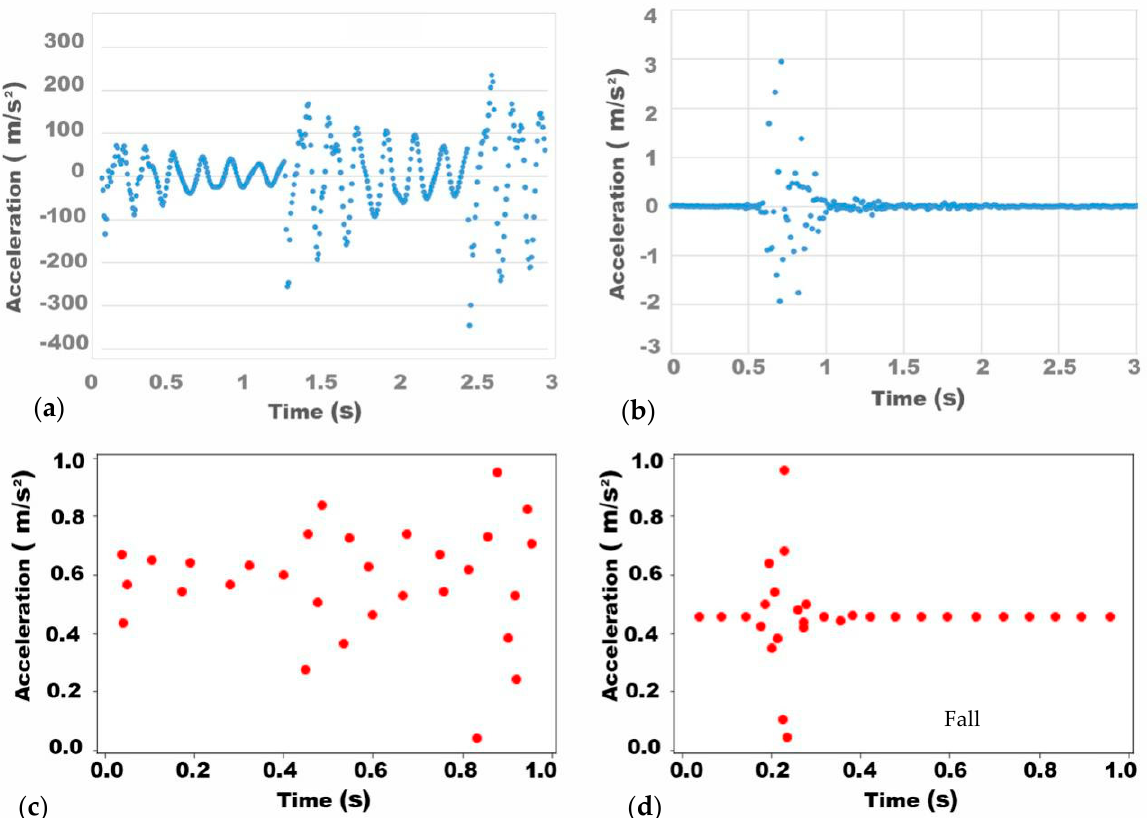
Figure 11. Standardized patterns for walking and fall. ( a ) original walking pattern; ( b ) original fall pattern; ( c ) simplified walking pattern; ( d ) simplified fall pattern.